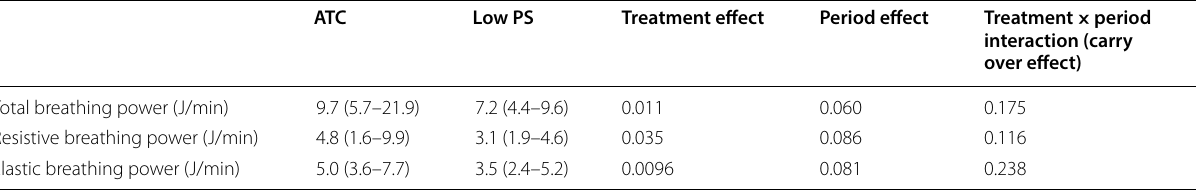
Table 3 Results of the cross-over design analysis for the breathing power (the primary end-point of the study) in the automatic tube compensation and the low-pressure support periods during spontaneous breathing trial in 20